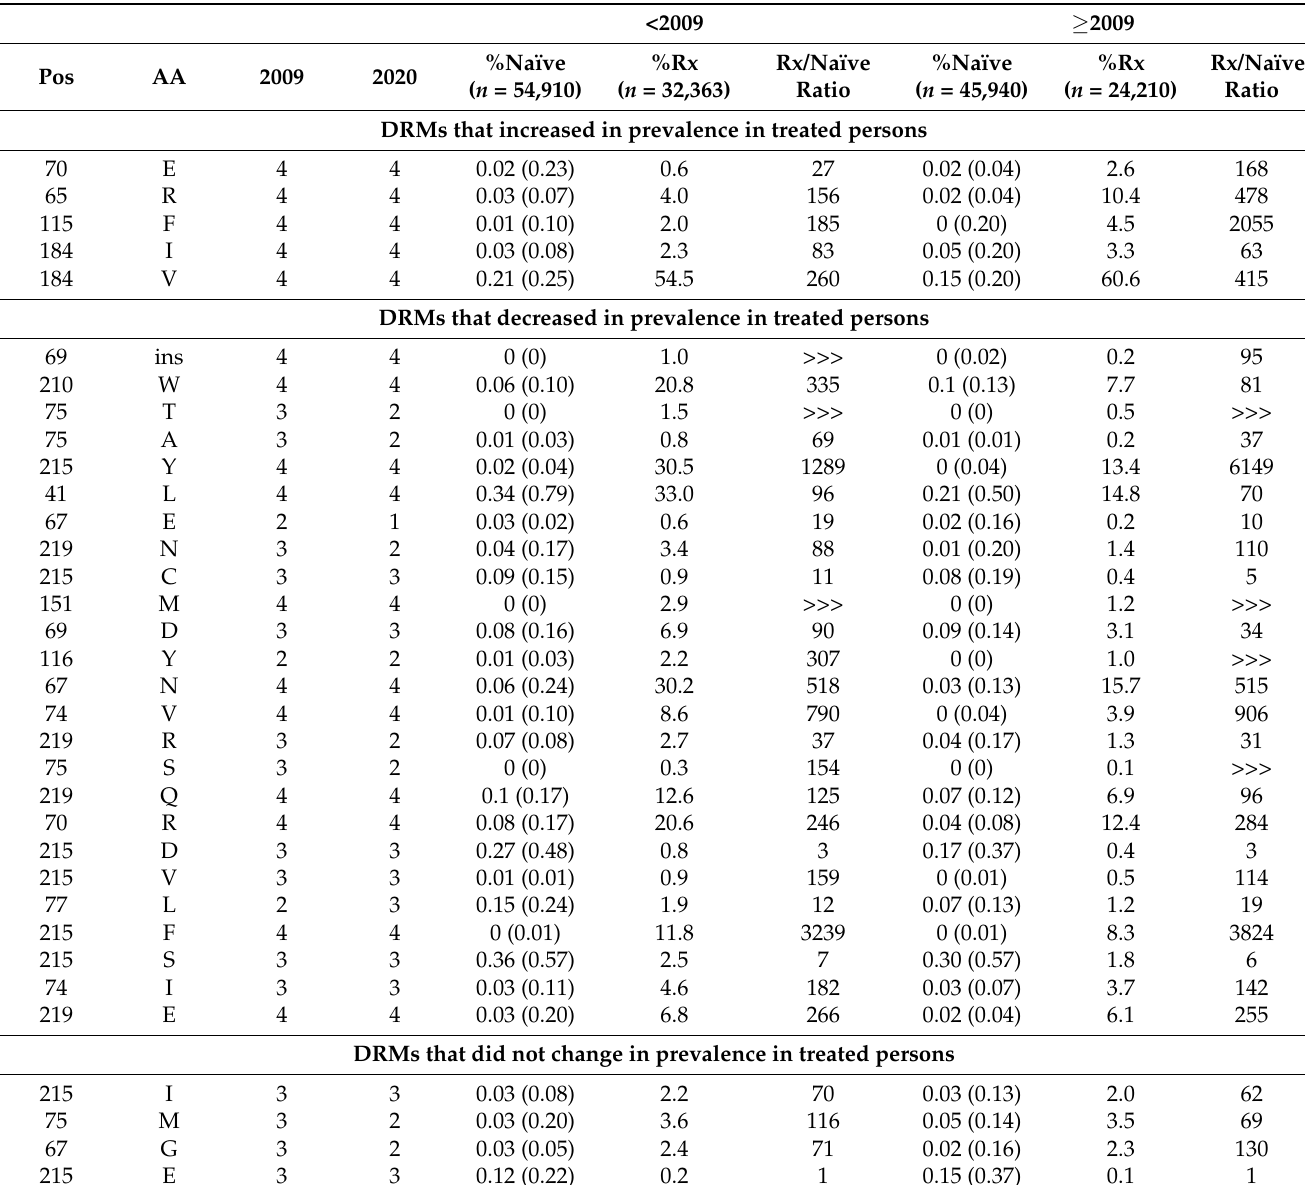
Table 1. Prevalence of Surveillance NRTI-Resistance Mutations in RTI-Naïve and NRTI-Experienced Persons before and after